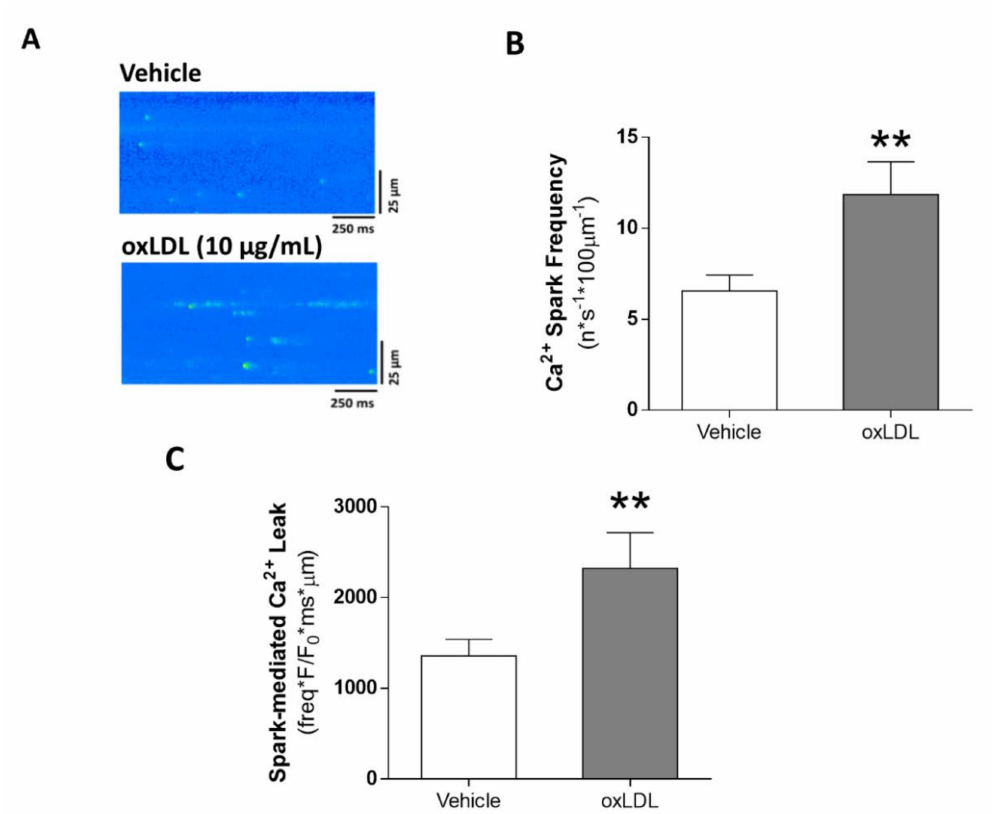
Figure 4. Acute e ff ects of oxLDL on diastolic Ca 2 + leak. ( A ) Representative line-scan images of Ca 2 +